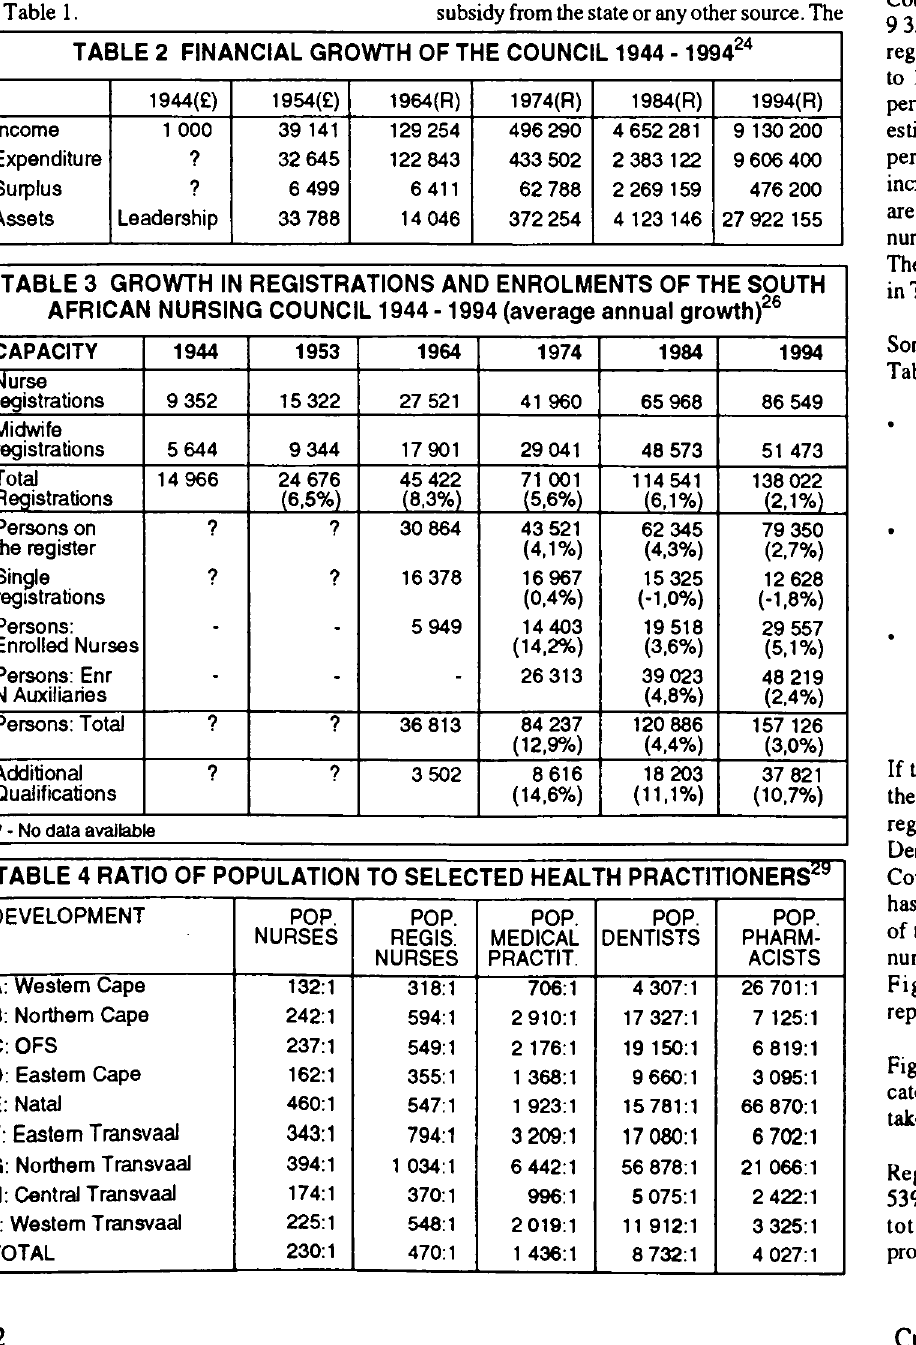
TABLE 3 GROWTH IN REGISTRATIONS AND ENROLMENTS OF THE SOUTH